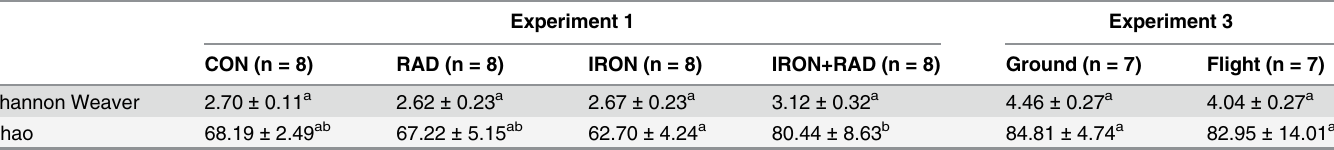
Table 1. Chao and Shannon Weaver indices for microbial populations in the feces of rats and mice exposed to various space-relevant environ- mental conditions.